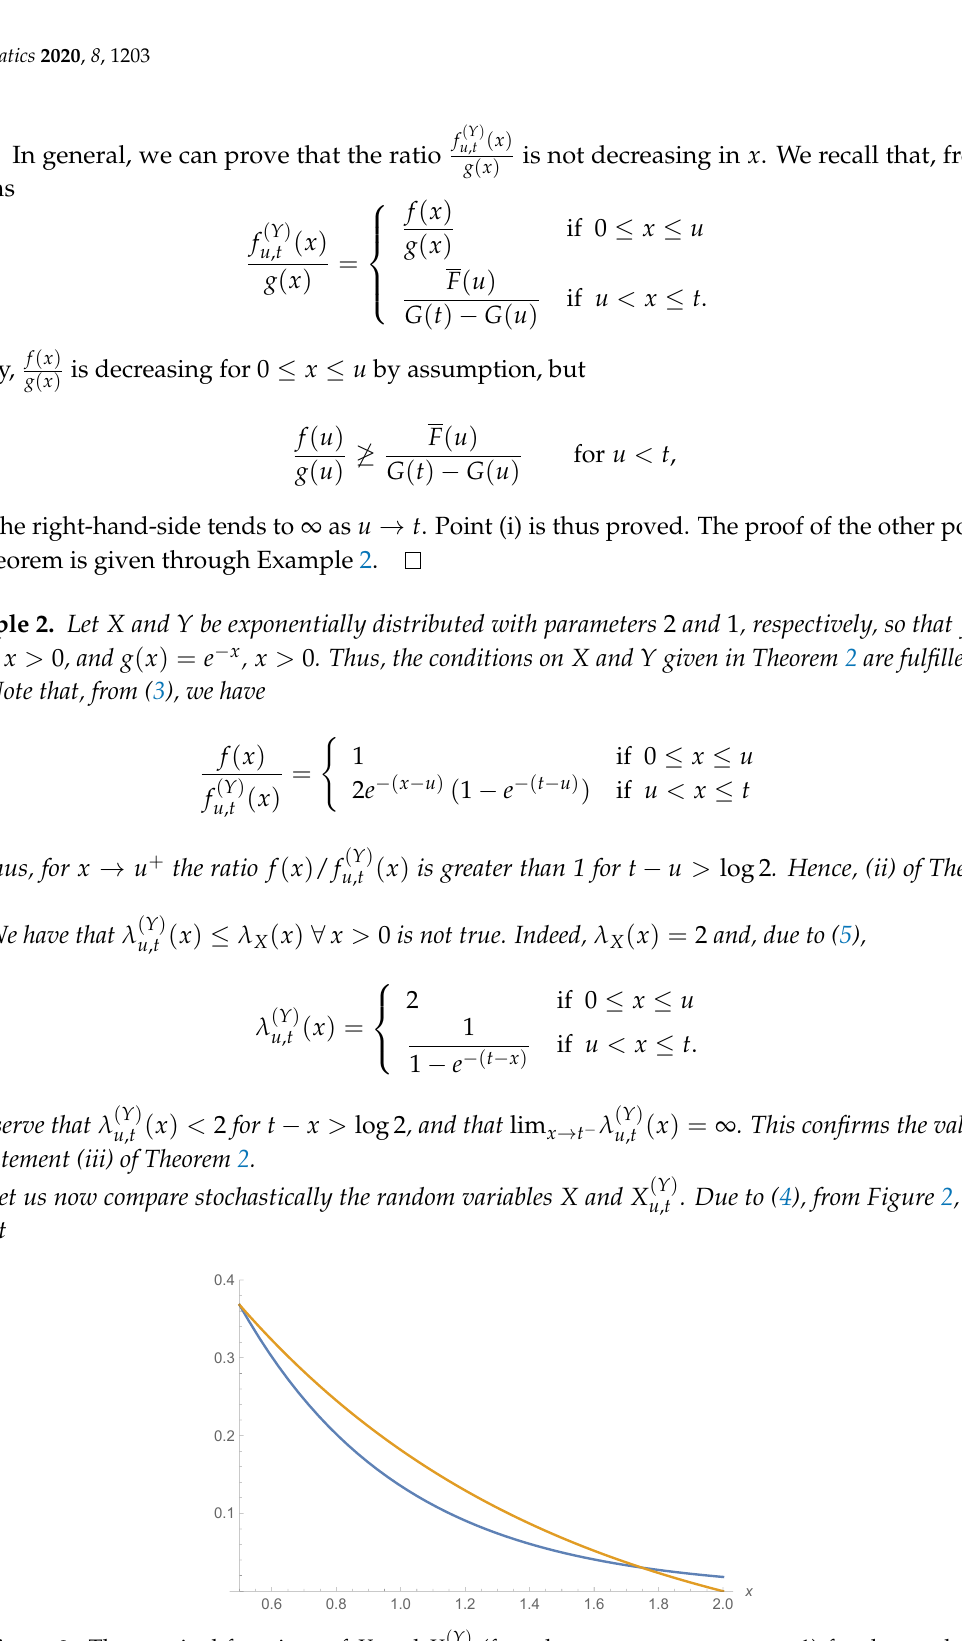
Figure 2. The survival functions of X and X variables considered in Example 2, for u = 0.5 and t =